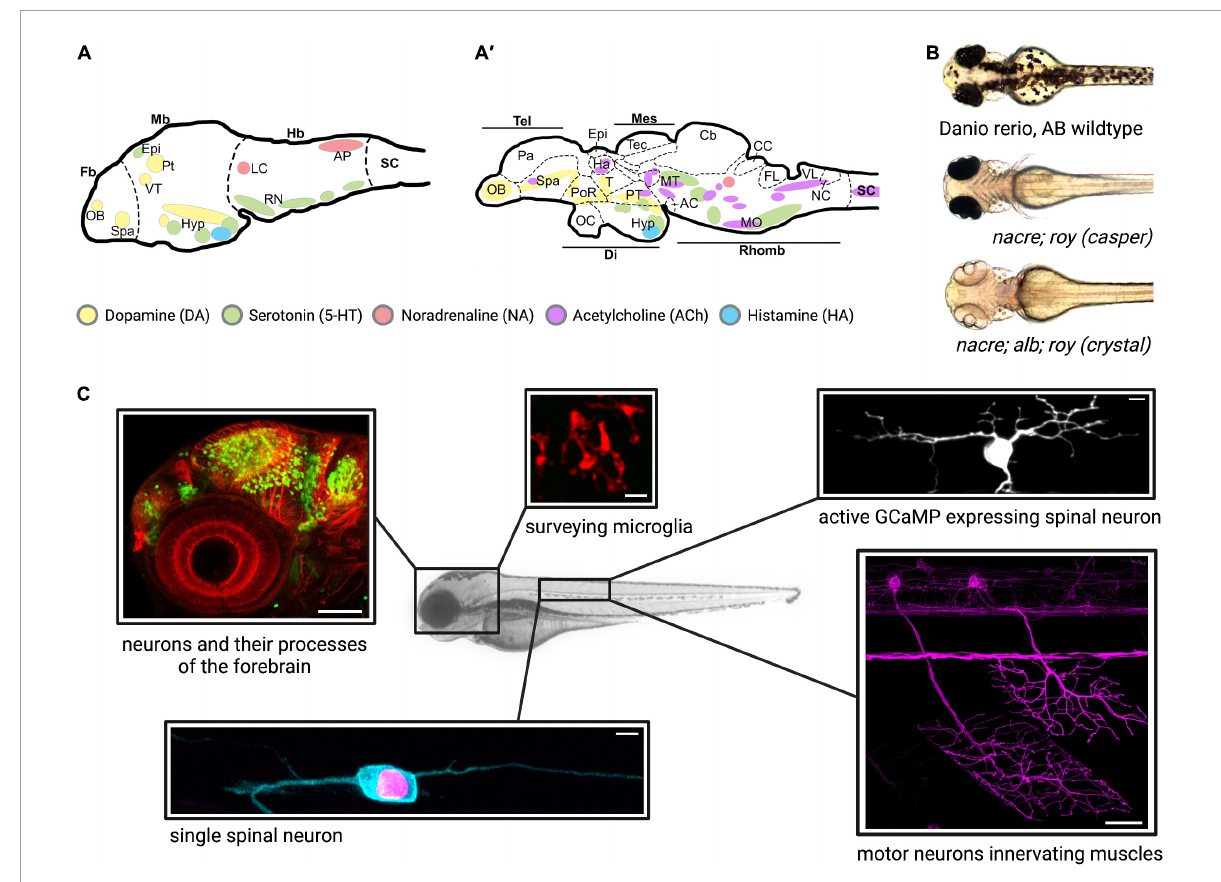
FIGURE1 (A,A (cid:48) ) Schematic illustration of the monoaminergic localities and anatomy of the zebrafish brain. The monoaminergic system is well developed in the zebrafish, with brain specific regions of neuronal clusters for the different neurotransmitters, dopamine (yellow), noradrenaline (red), serotonin (green), acetylcholine (purple), and histamine (blue). (A) The brain is developed and CNS fully functional in the larval zebrafish from as early as 3 dpf. (A (cid:48) ) The schematic lateral view of the adult zebrafish brain shows a well-defined and complex architecture. Schematic representation and annotations have been adapted from (A) (Alunni et al., 2013) and (B) Wullimann et al. (2011), Parker et al. (2013). AC, ansulate commissure; AP, area postrema; Cb, cerebellum; CC, crista cerebellaris; Di, diencephalon; Epi, epiphysis; Fb, forebrain; FL, facial lobe; Ha, habenula; Hb, hindbrain; Hyp, hypothalamus; LC, locus coeruleus; Mb, midbrain; Mes, mesencephalon; MO, medulla oblongata; MT, mesencephalic tegmentum; NC, nucleus commisuralis; OB, olfactory bulb; OC, optic chiasma; Pa, pallium; PoR, preoptic region; Pt, pretectum; PT, posterior tuberculum; Rhomb, rhombencephalon; RN, raphé nuclei; SC, spinal cord; Spa, subpallium; T, thalamus; Tec, tectum; Tel, telencephalon; VT, ventral thalamus; VL, vagal lobe. (B) The zebrafish is optically transparent during the first week of development. Lines for mutations in genes controlling pigment cell formation ( nacre w2 / w2 , roy a9 / a9 ) as well as melanin production ( alb b4 / b4 ) have been generated allowing for non-invasive in vivo imaging. Images in (B) have been taken and adapted from Antinucci and Hindges (2016) gp. (C) Examples of